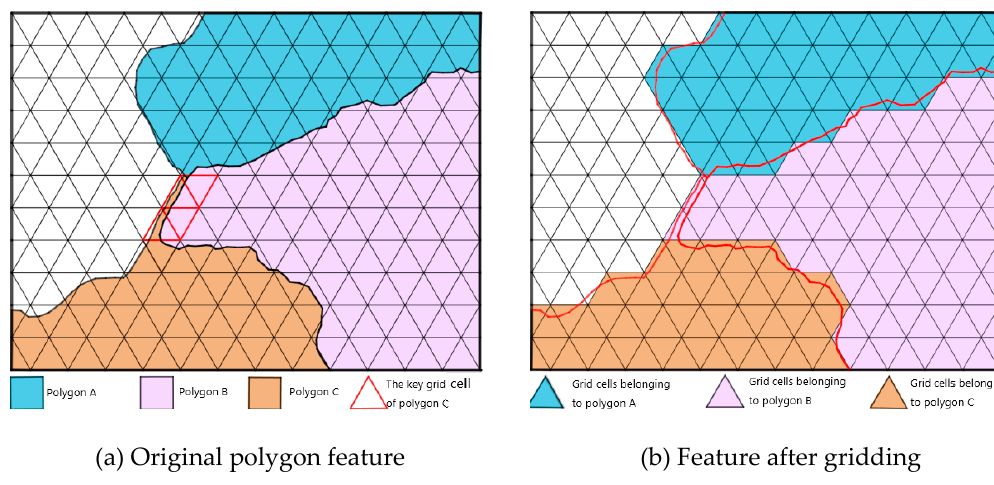
Figure 5. Change from meet to disjoint after gridding of polygon features.